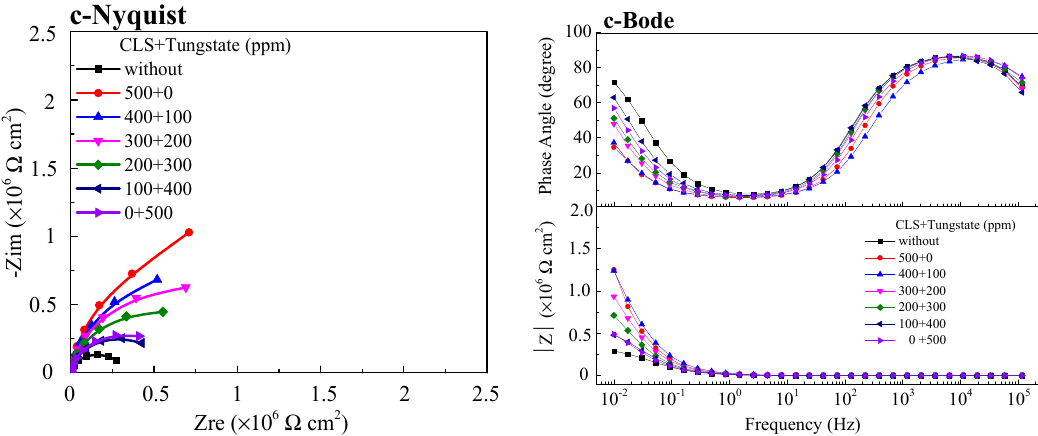
Figure 5. Nyquist plots and Bode plots of Q235 carbon steel in test solution with di ff erent compound inhibitors: ( a ) CLS with molybdate; ( b ) CLS with stannate; ( c ) CLS with tungstate.